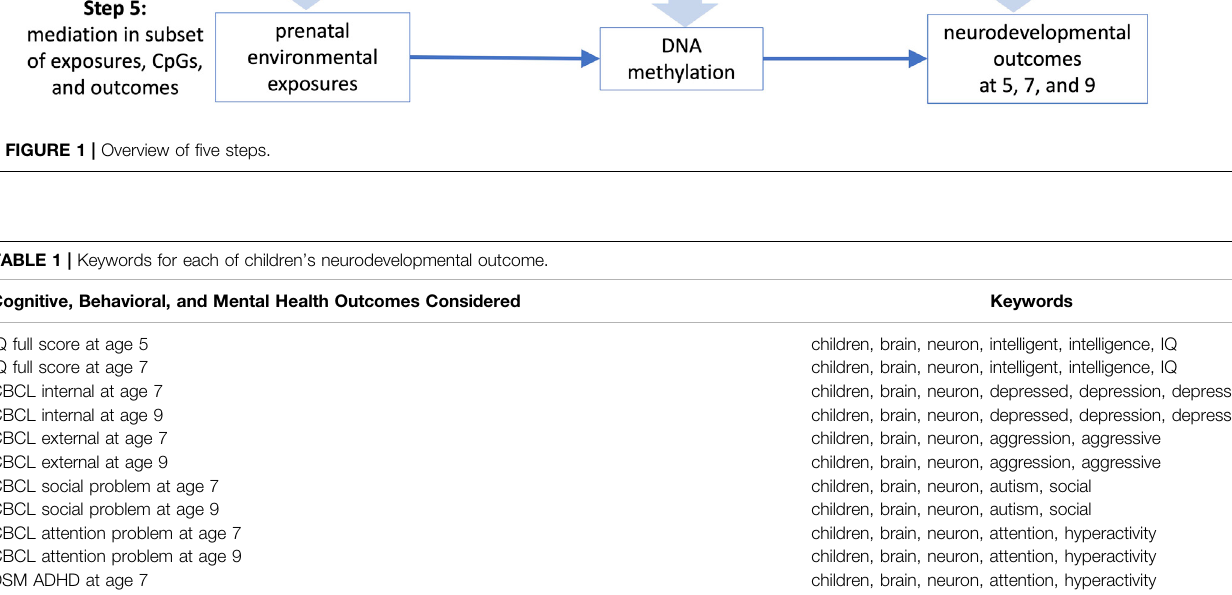
each outcome, we applied false discovery rate (FDR) with adjusted-p < 0.05 as the threshold to correct for multiple comparisons.